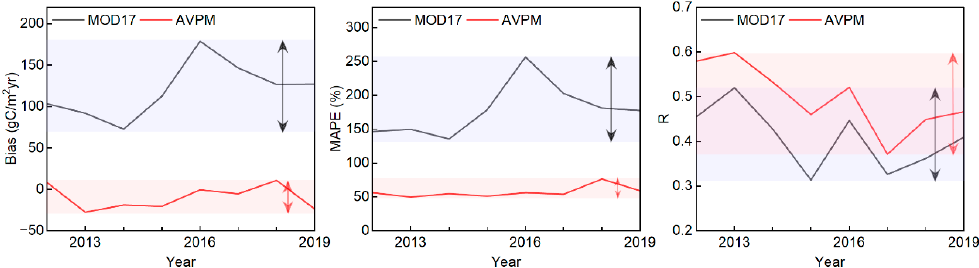
Figure 2. The average bias, mean absolute percentage error (MAPE), and Pearson’s correlation coefficient (r) from 2012 to 2019 for the MOD17 and AVPM. The black arrows indicate the variation range of the MOD17’s accuracy index. The red arrows indicate the variation range of the AVPM’s accuracy